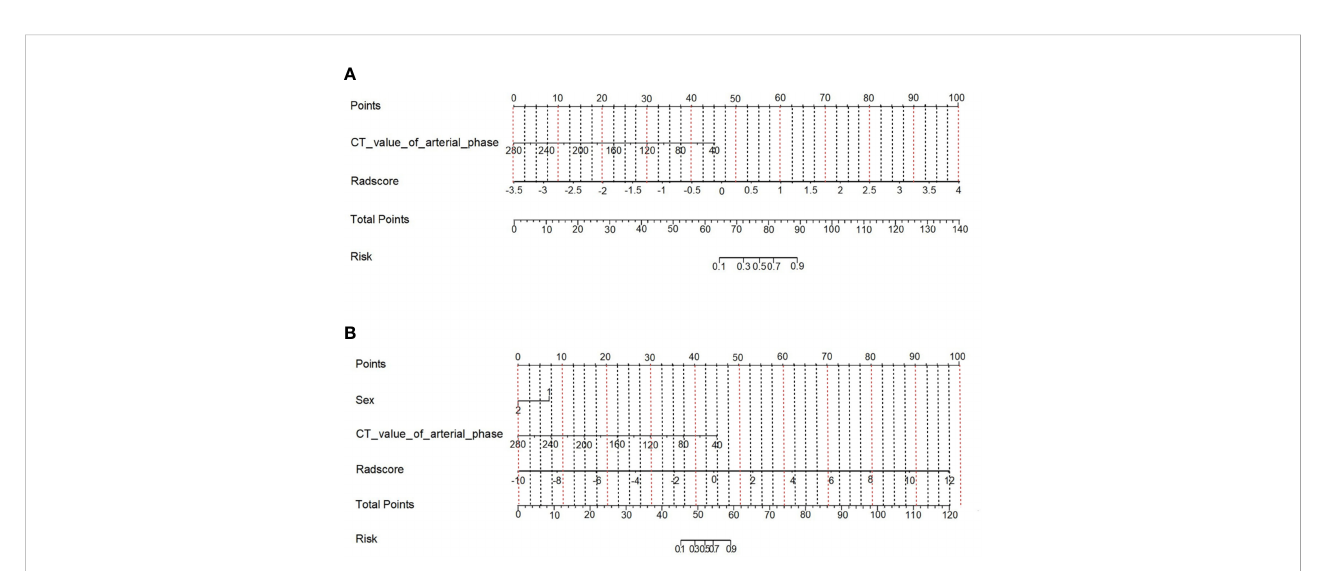
FIGURE 6 Nomogram of the prediction model combining clinical risk factors and CT radiomics features. (A) Model 1; (B) Model